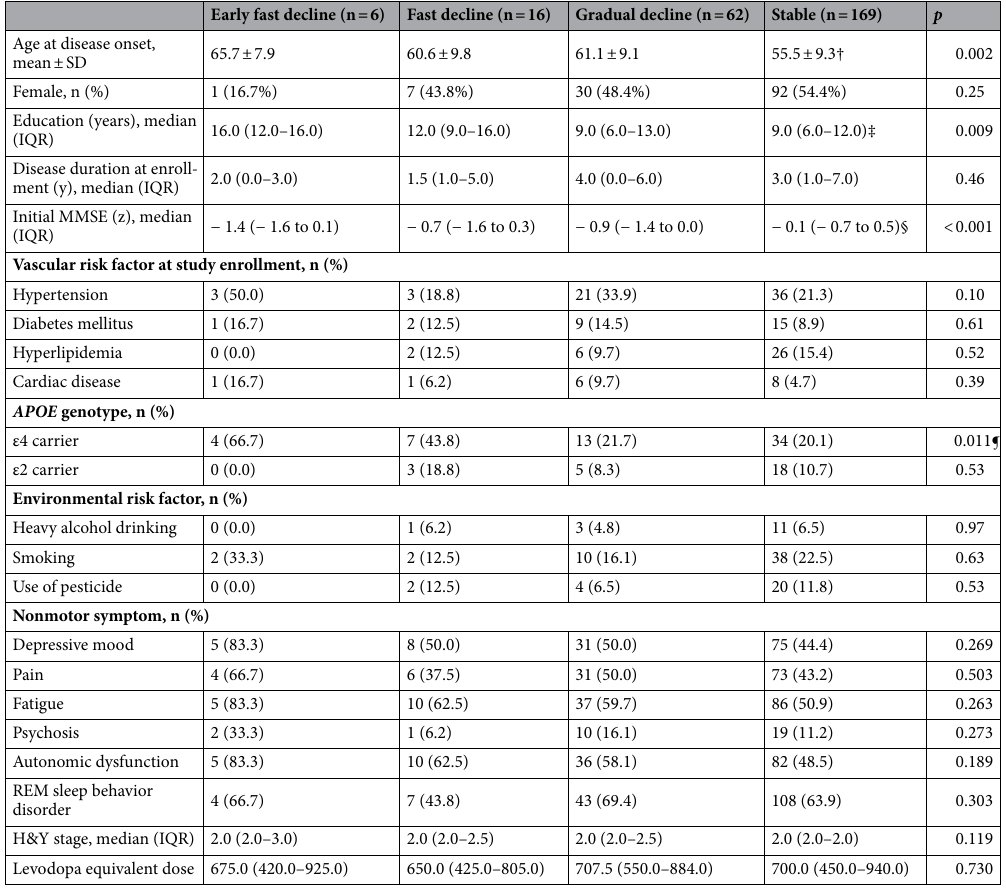
Table 1. Patient demographics and clinical characteristics at study enrollment. H&Y Hoehn and Yahr; MMSE mini-mental state exam; RBD Rapid eye movement sleep behavior disorder. † Significant difference compared